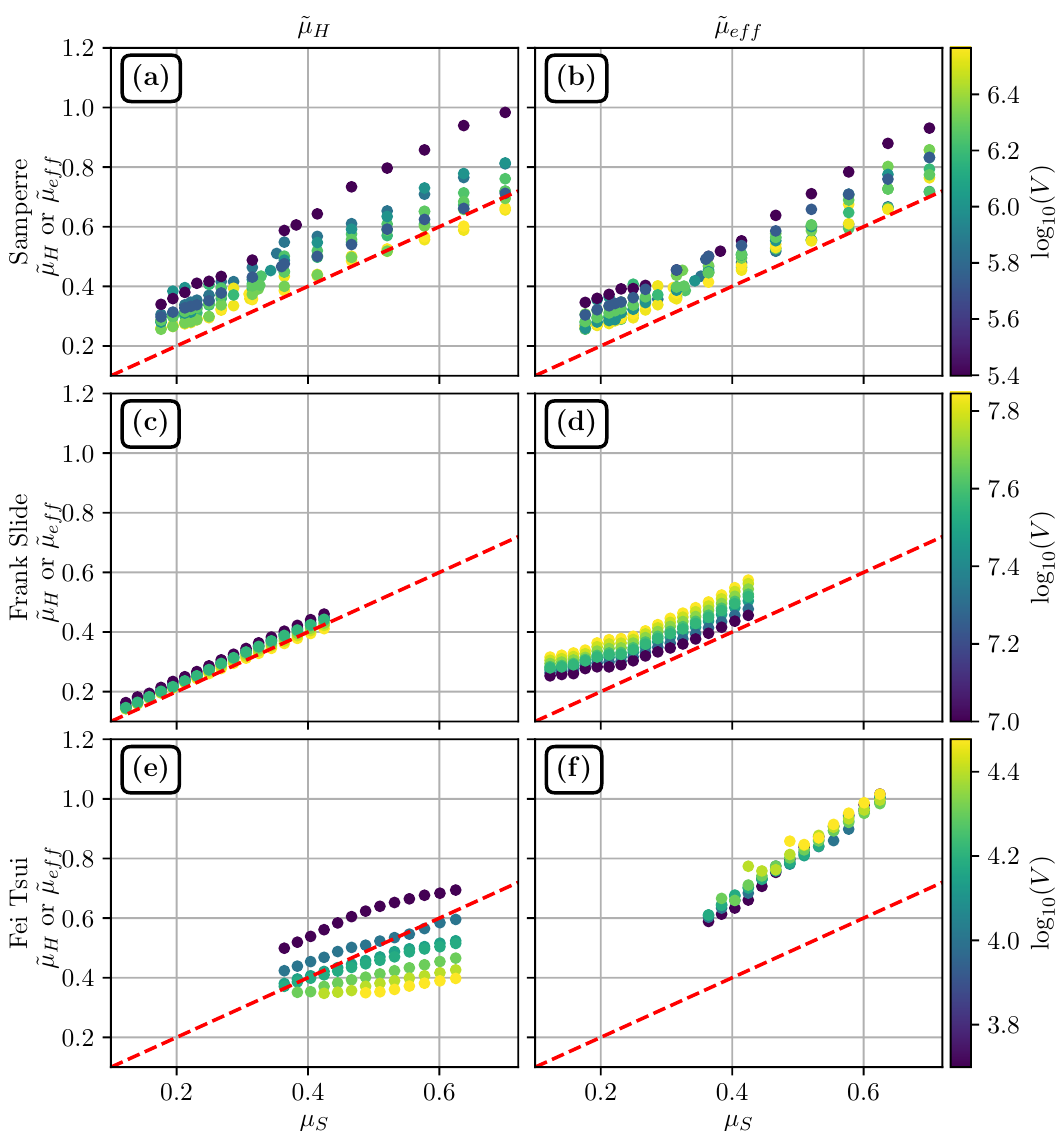
Figure 11. ˜ µ ef f and ˜ µ H computed from simulations results, plotted against µ S . ( a ) and ( b ) ˜ µ H against µ S and ˜ µ ef f against µ S (respectively) for the Samperre case study. ( c ) and ( d ) ˜ µ H against µ S and ˜ µ ef f against µ S (respectively) for the Frank Slide case study. ( e ) and ( f ) ˜ µ H against µ S and ˜ µ ef f against µ S (respectively) for the Fai Tsui debris slide case study. Color scale gives the volume (in logarithmic scale) of the simulation. The red dashed lines correspond to µ H = µ S and µ ef f = µ S